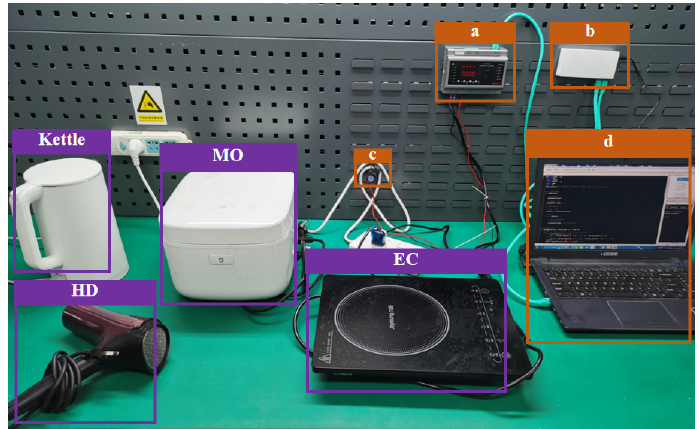
Figure 9. Acquisition environment and hardware connection of HASED dataset (a is used for data collection and transmission, b can realize network sharing, c is an electrical signal transformer, and d is a data receiving and processing terminal). Table 1. Number of samples for each type of load within different datasets. PLAID